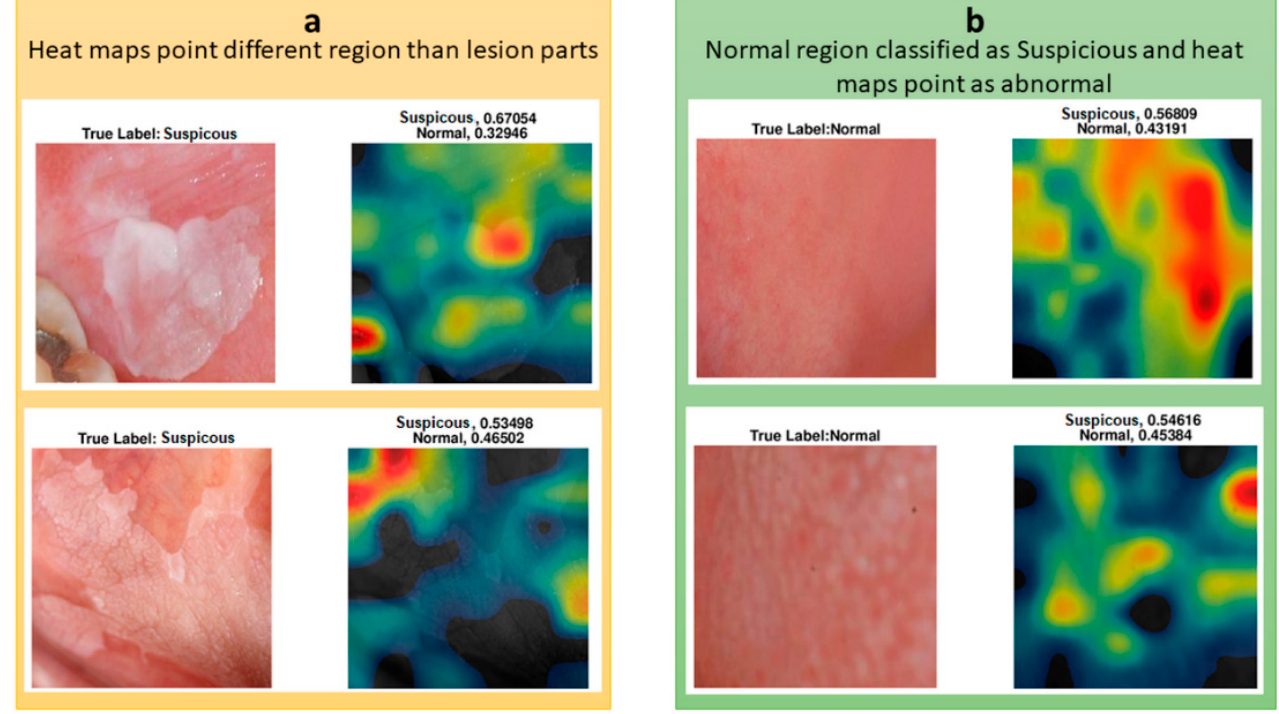
Figure 8. ( a ) Heat maps do not point to lesion region. ( b ) Heat maps of misclassified “normal” images.